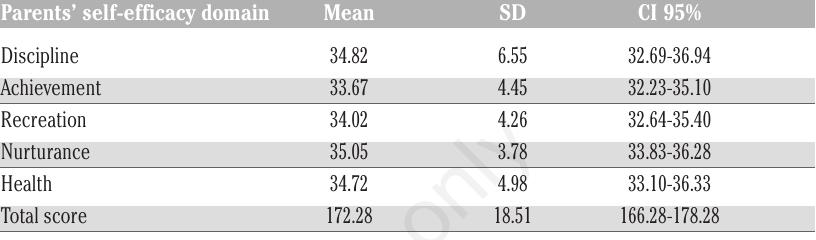
Table 1. Overview of total scores and parents’ self-efficiency sub-scale (n=39).